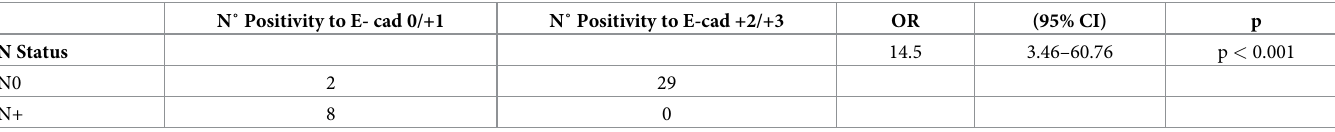
Table 3. Multivariate analysis between low E-cadherin expression (E-cad 0 / +1) and high E-cadherin expression (E-cad +2 / +3). N˚ Positivity to E- cad